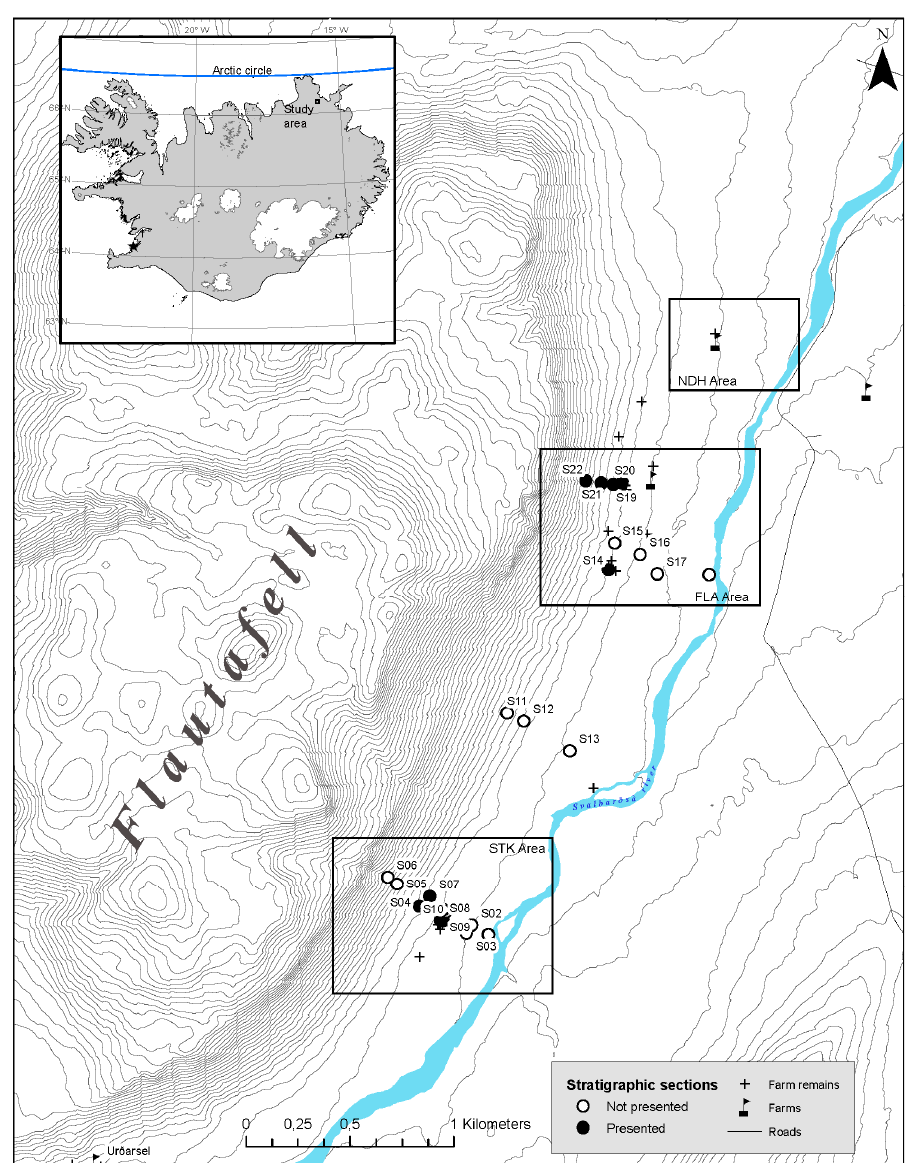
Figure 1. Location of the study area in northeastern Iceland and the location of sites used for stratigraphical study on the slopes of Mt. Flautafell. The three sectors in the study, Flautafell farm (FLA), Stekkur (STK), and Norður H ú s (NDH), are delineated by the